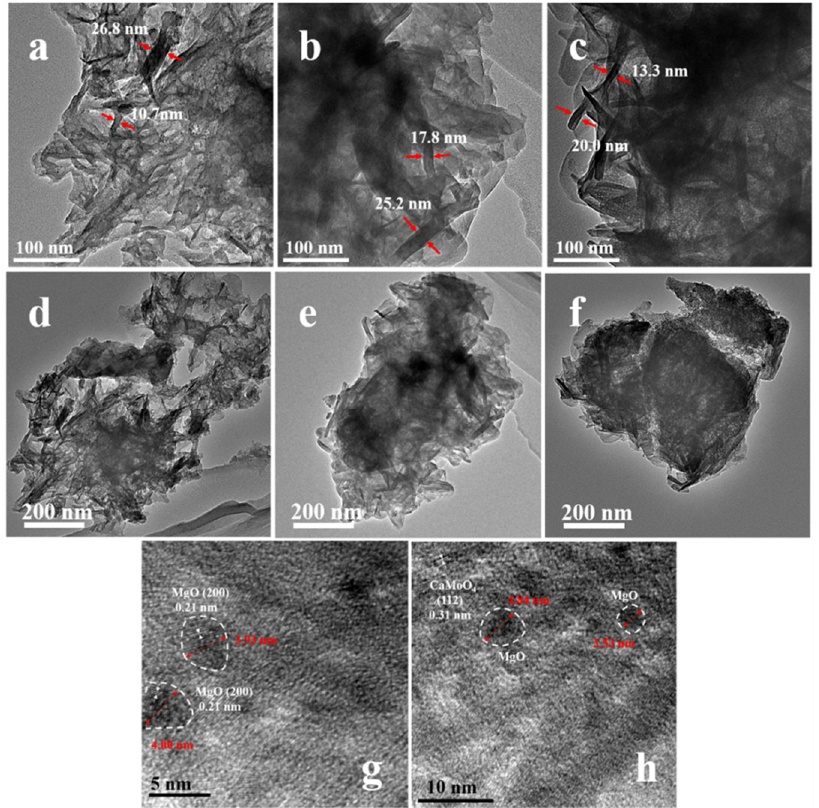
Figure 4. TEM images of fresh catalysts: ( a , d ) 12.5 wt% Mo/LDO; ( b , e ) 22.3 wt% Mo/LDO; ( c , f ) 30.1 wt% Mo/LDO; and images of ( g ) MgO and ( h ) CaMoO 4 in 22.3 wt% Mo/LDO.